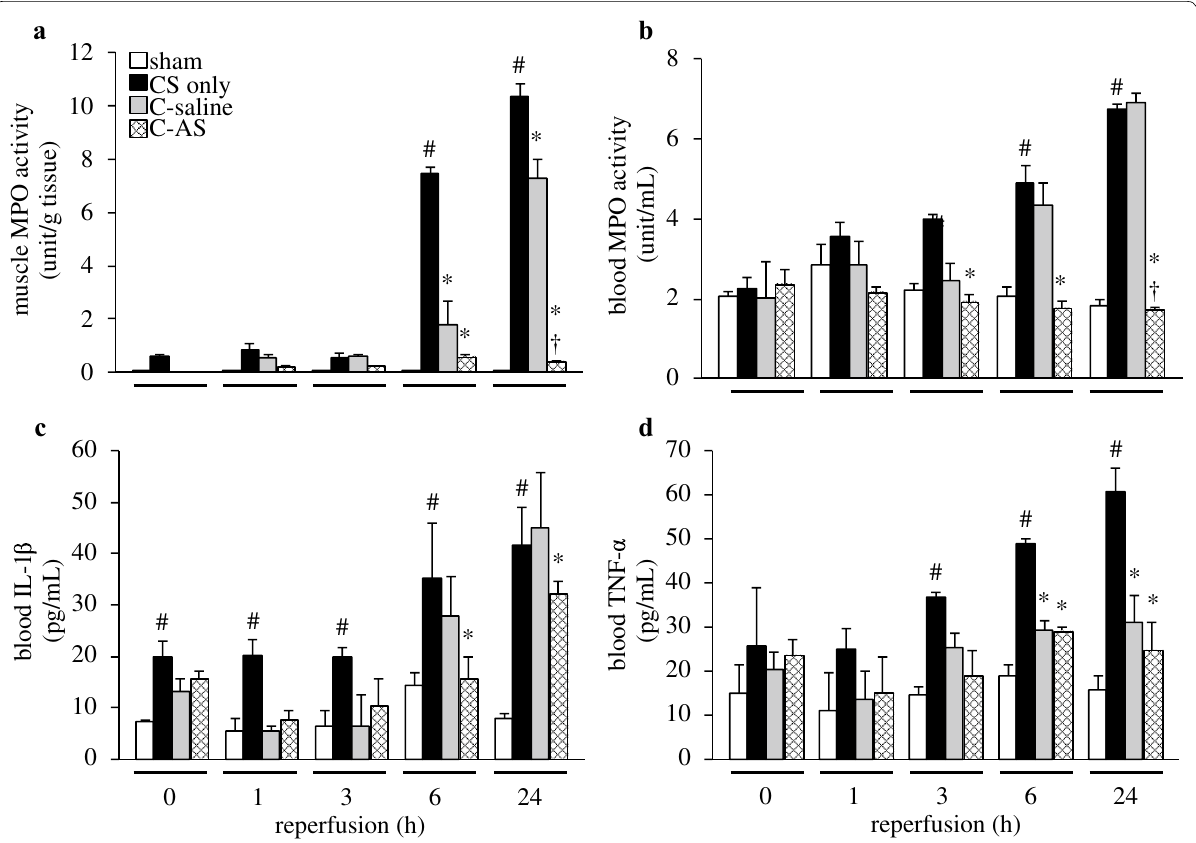
Fig. 3 Effect of fluid resuscitation on inflammatory mediators in CS rats. a Muscle MPO activity, b blood MPO activity, c blood IL-1β, and d blood TNF-α. White bar sham, black bar CS-only, gray bar C-saline, and shaded bar C-AS. Values represent mean * p < 0.05 versus CS-only group, and † p < 0.05 versus C-saline group (Tukey’s test). CS crush syndrome, MPO myeloperoxidase, IL-1β